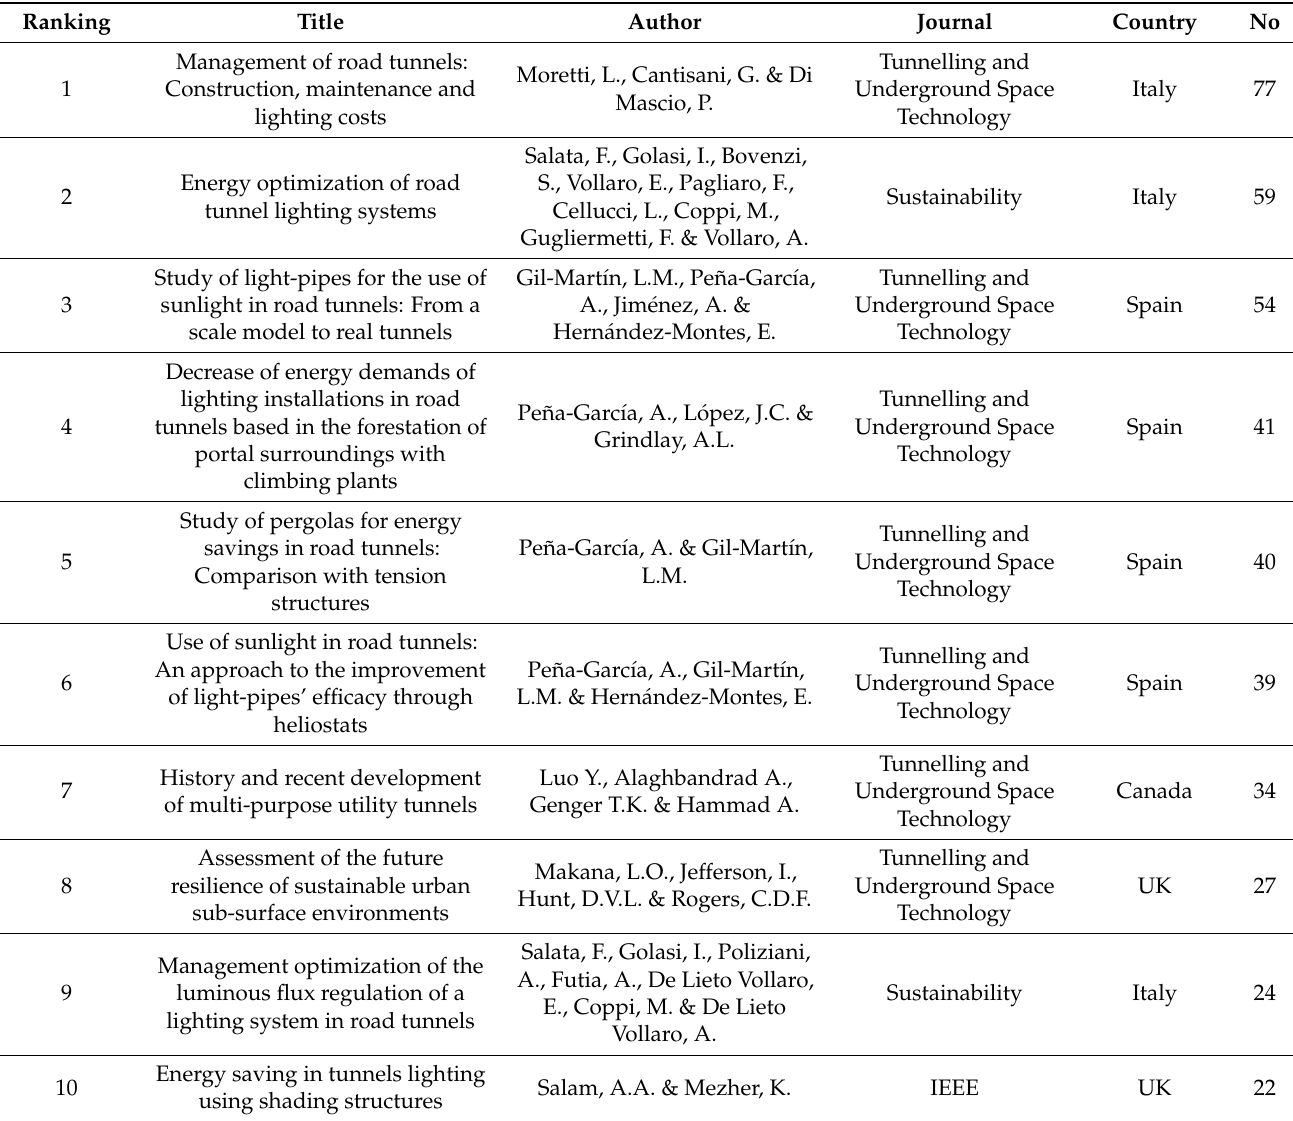
Table 6. Ranking of most cited